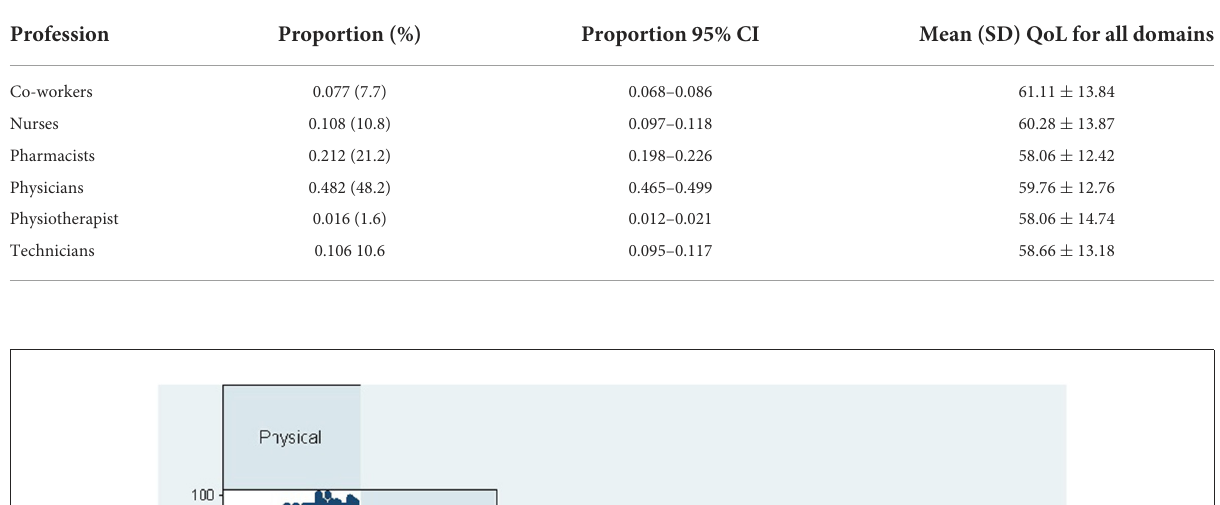
TABLE 3 Quality of life of different categories of health care workers.